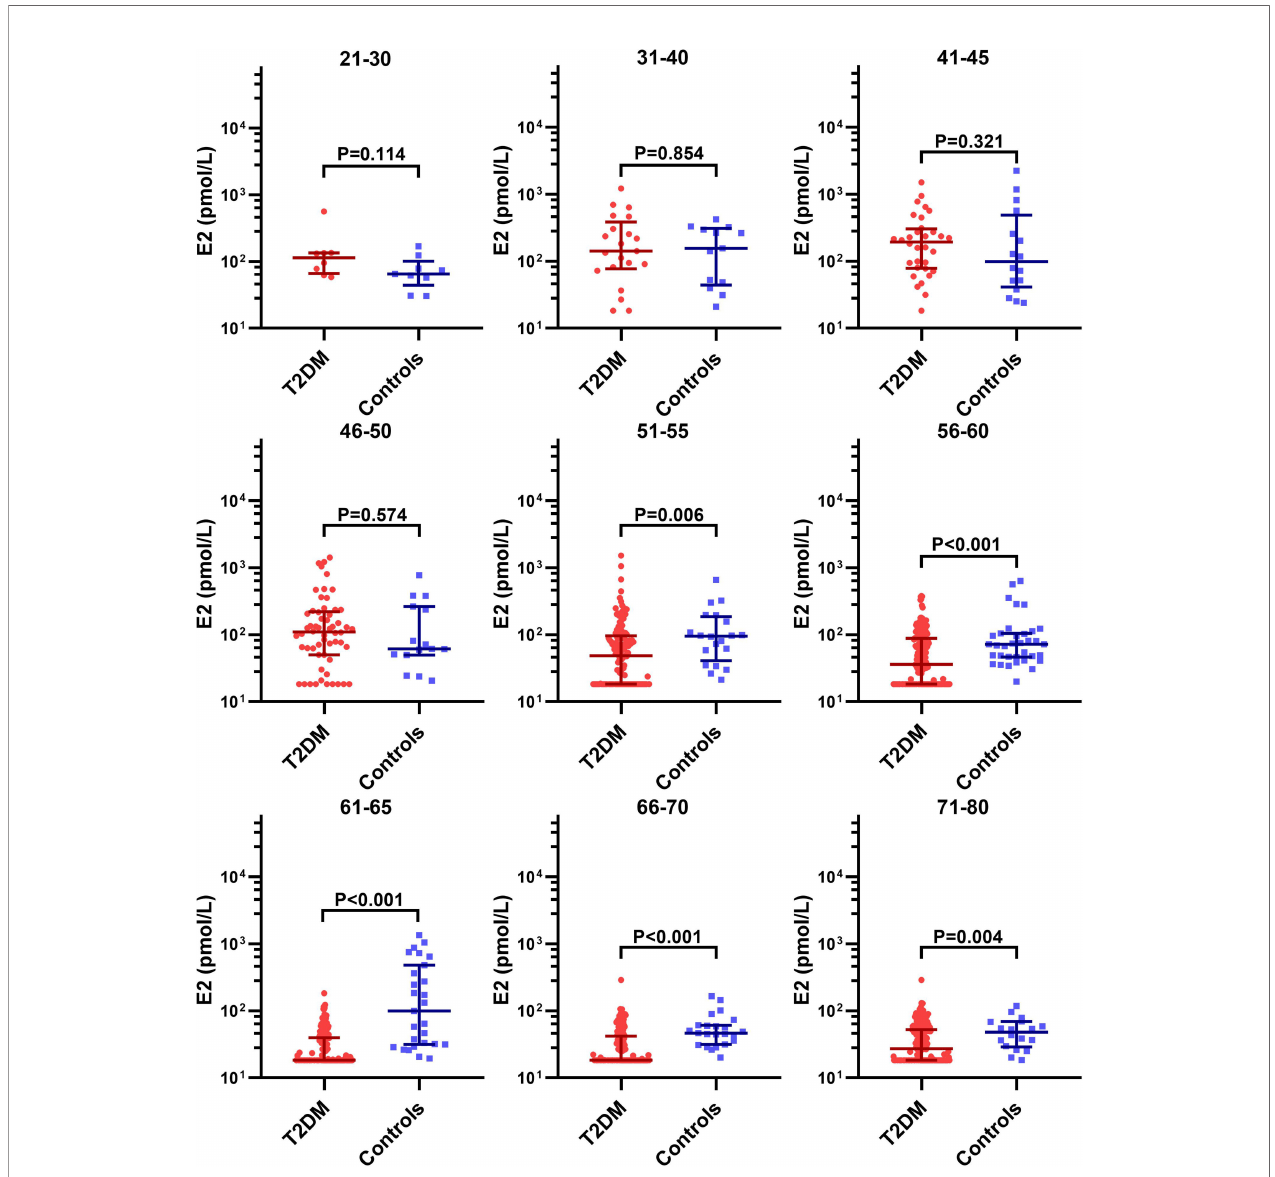
FIGURE 4 | Difference in the circulating E2 level between patients with T2DM and non-T2DM controls strati fi ed by